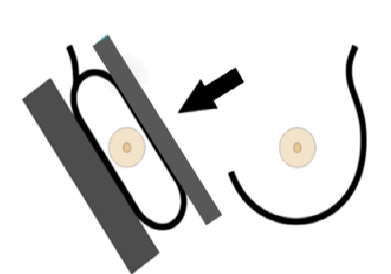
Figure 4. Mediolateral-oblique imaging technique [22].